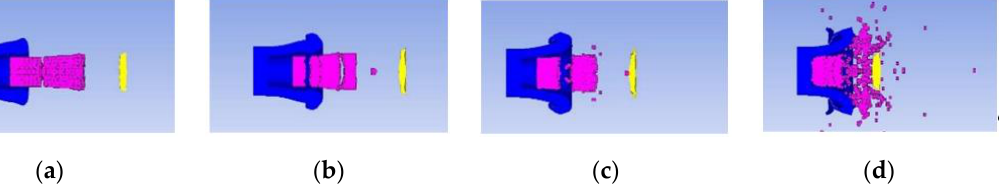
Figure 8. Warhead deformation and fragment distributions after penetrating RHA steel target at different impact velocities: ( a ) v 0 = 800 m/s, ( b ) v 0 = 1200 m/s, ( c ) v 0 = 1400 m/s, and ( d ) v 0 = 1600 m/s.